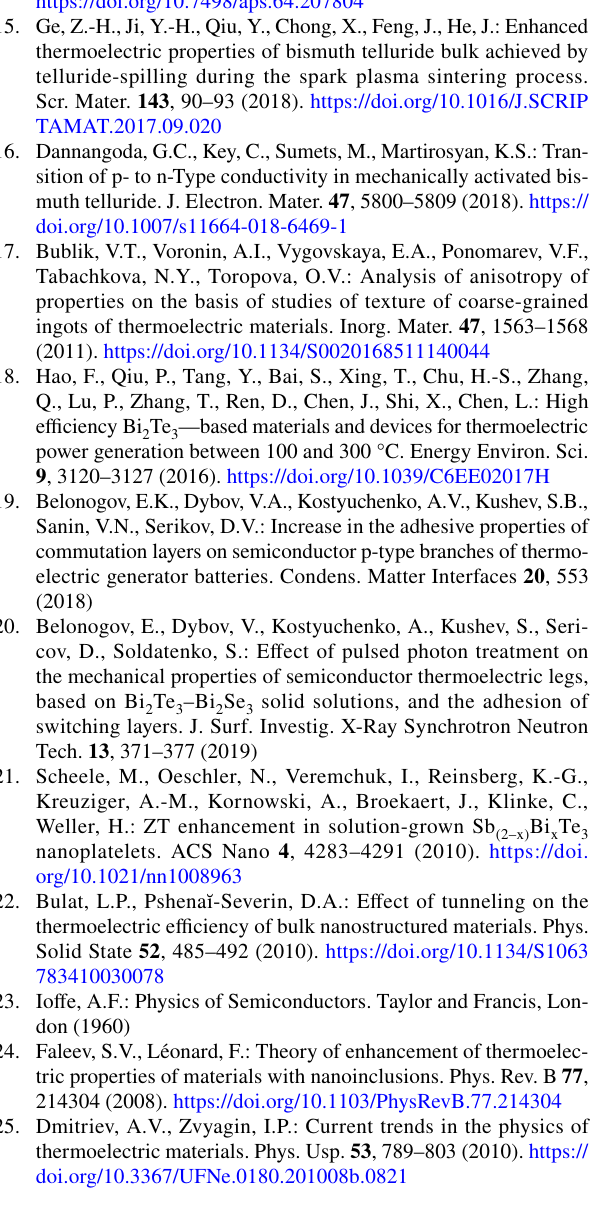
Tabachkova, N.Y., Toropova, O.V.: Analysis of anisotropy of properties on the basis of studies of texture of